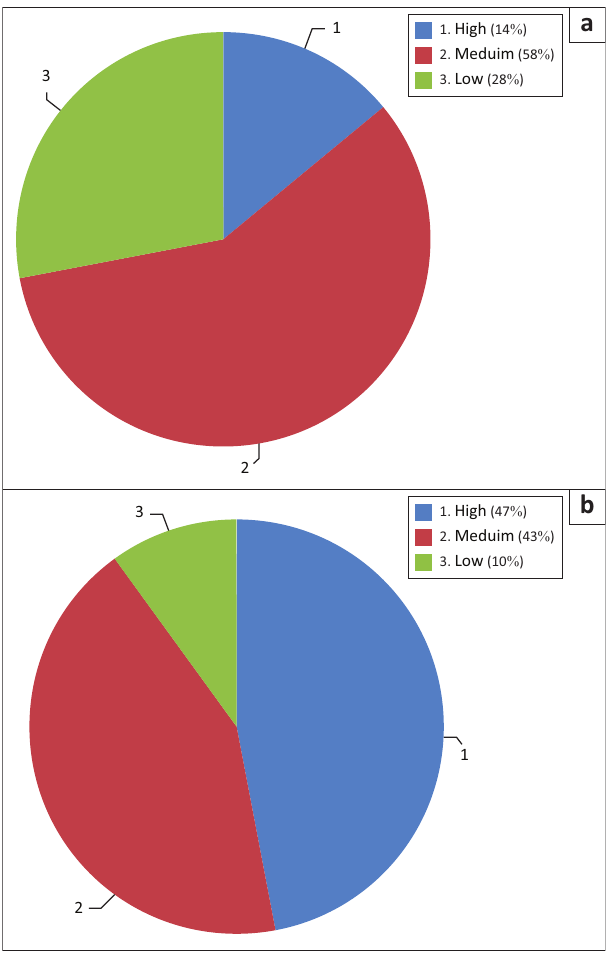
FIGURE 2: Consideration of seismic hazard by professionals of Bureau d’Etudes Techniques (BET), according to architects and engineers. (a) Architects, (b) Engineers.